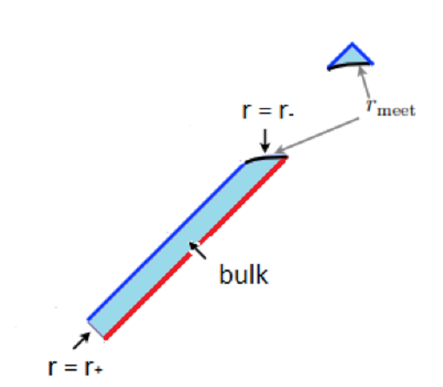
Figure 8 . Asymptotic contributions for the rotating